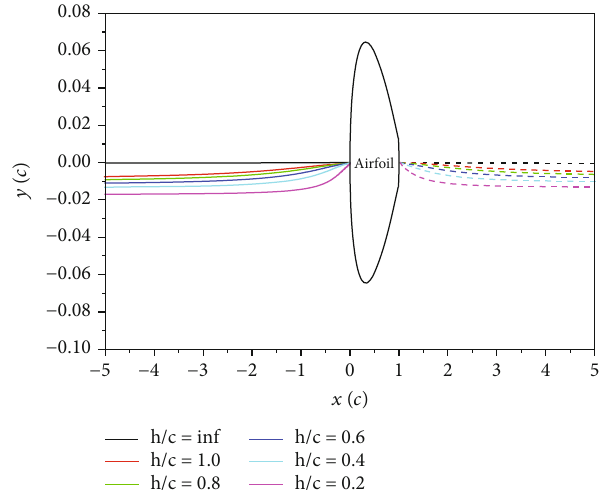
Figure 12: Leading and trailing edge stagnation streamlines for the no-blowing case at α = 0 °